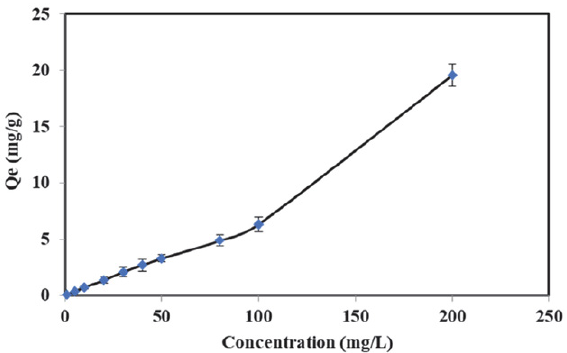
Figure 7. The adsorption capacity of NPs as a function of the initial concentration of metformin under the optimized conditions; pH, 7; T, 25 °C; t , 20 min; sample volume, 1.0 mL; adsorbent mass, 40 mg; number of replicates, 3.